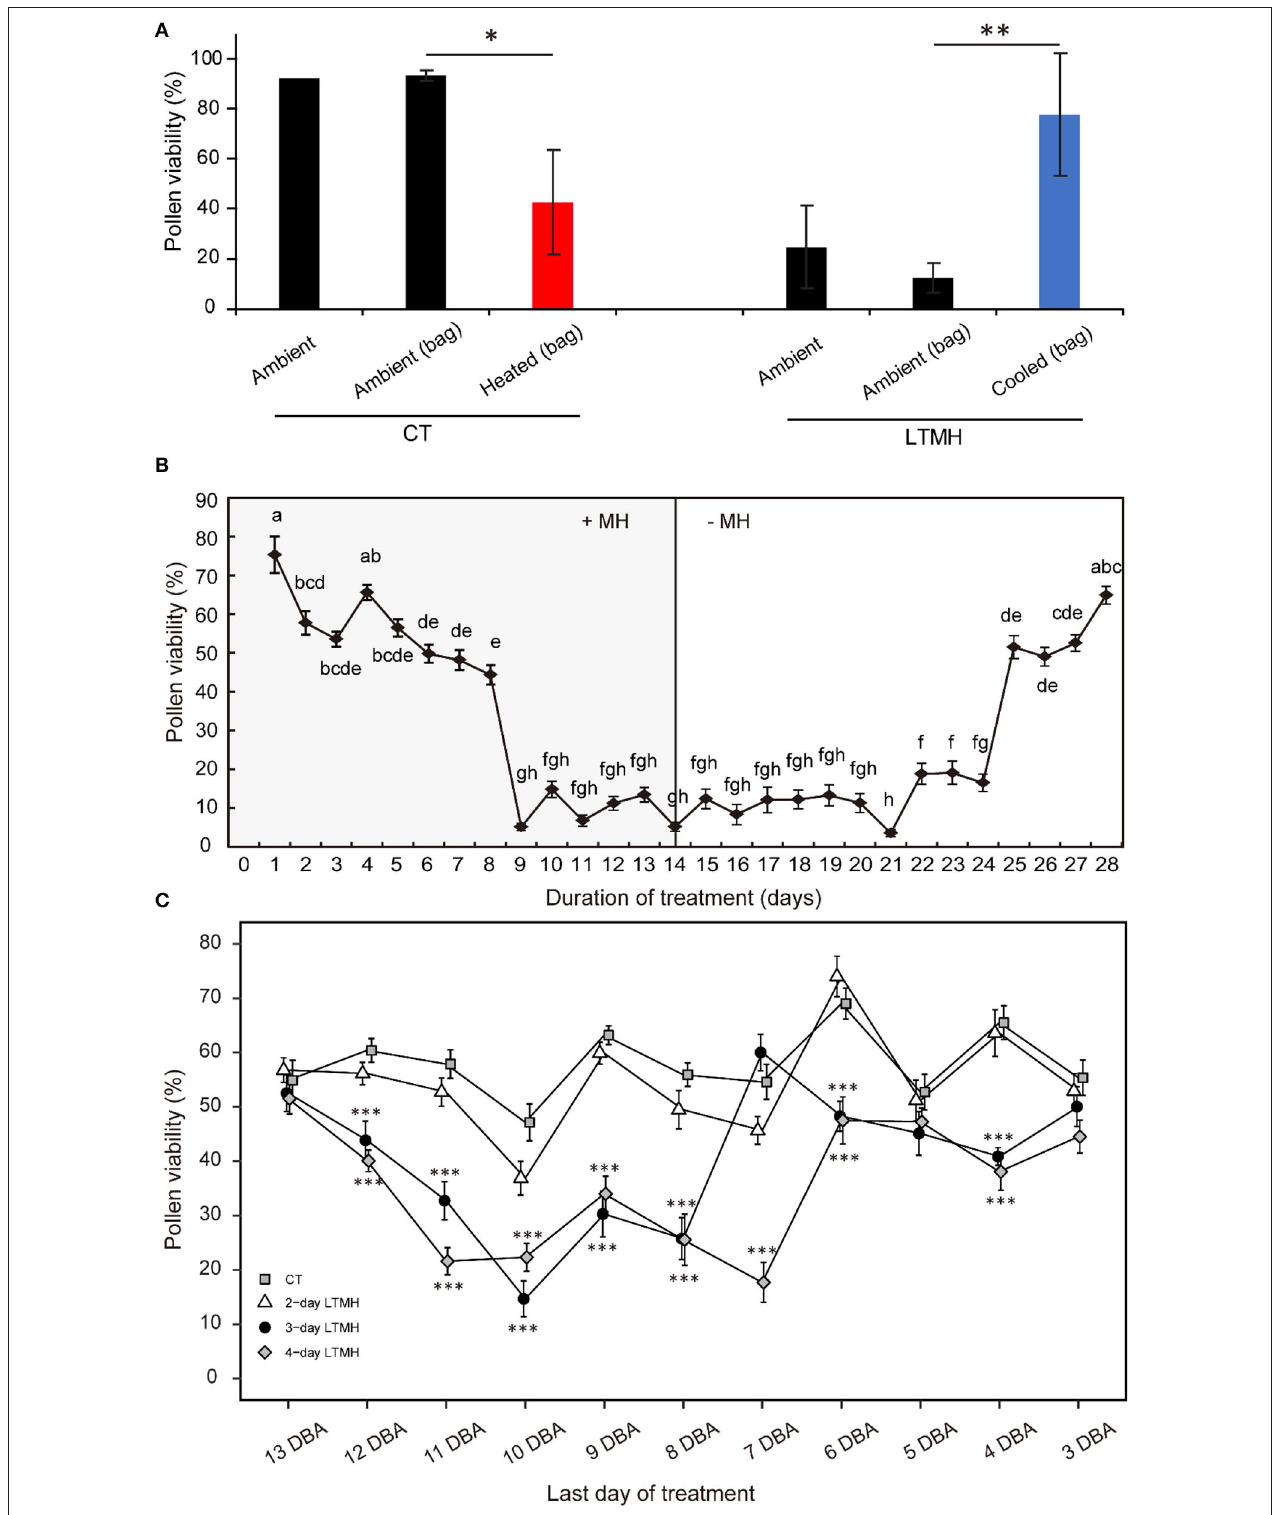
FIGURE 1 | The effects of long-term mild heat location, timing, and duration on viability of mature pollen. (A) Local temperature treatments: plants were grown in control (CT) or long-term mild heat (LTMH) conditions, and flower trusses were either exposed to the ambient temperature directly (“ambient”), to the ambient temperature by flushing ambient air through a bag around the truss [“ambient (bag)”], or reduced or increased temperature by flushing air of modified temperature